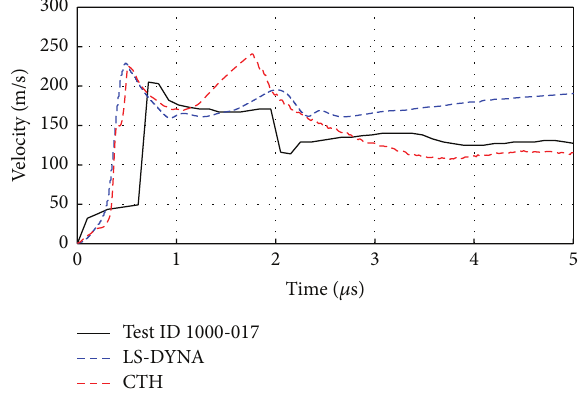
Figure 14: Free surface velocity comparison of Test 1000-017 (impact velocity: 5.063